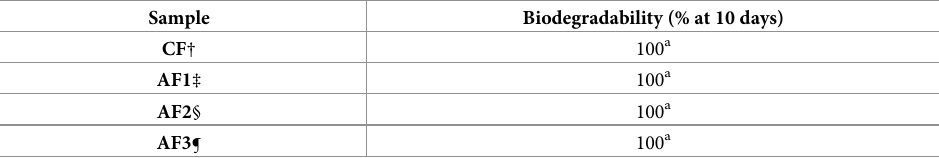
� Each value represents the mean of 3 replicates with the corresponding standard deviation. Data were statistically analysed with multiple range test, using the method of least significant difference (LSD) Fisher. Different lowercase letters denote statistically significant differences (p <